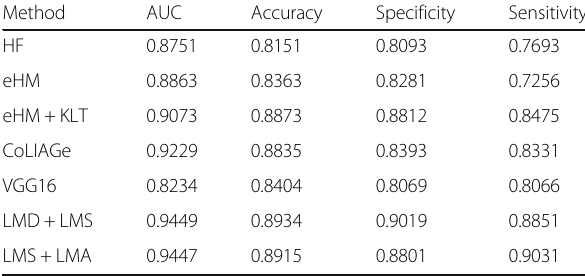
Table 8 Four evaluation measurements for seven methods Method